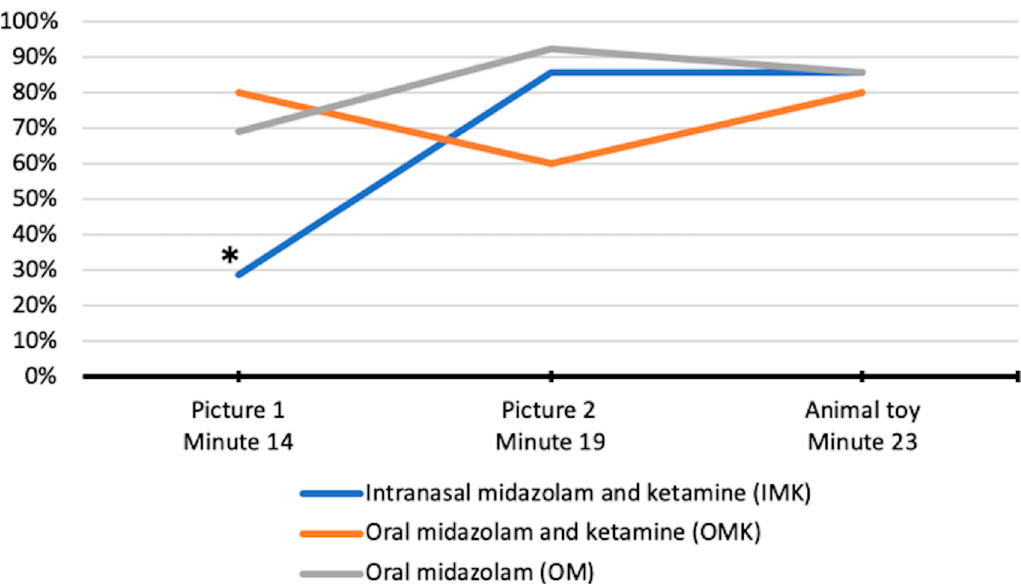
Figure 4. Comparison of the percentage of children who did not recall the pictures and the animal toy in each sedative group. * Differences between amnesia of picture 1 and animal toy (McNemar p = 0.003) and amnesia of picture 1 and picture 2 (McNemar p = 0.006) in children who received the intranasal midazolam and ketamine.